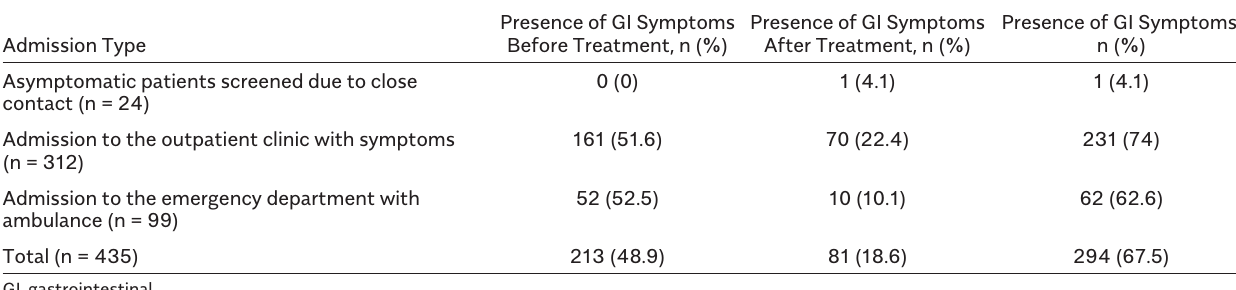
Table 1. Distribution of the Presence of GI Symptoms According to the Method of Admission of the Patients